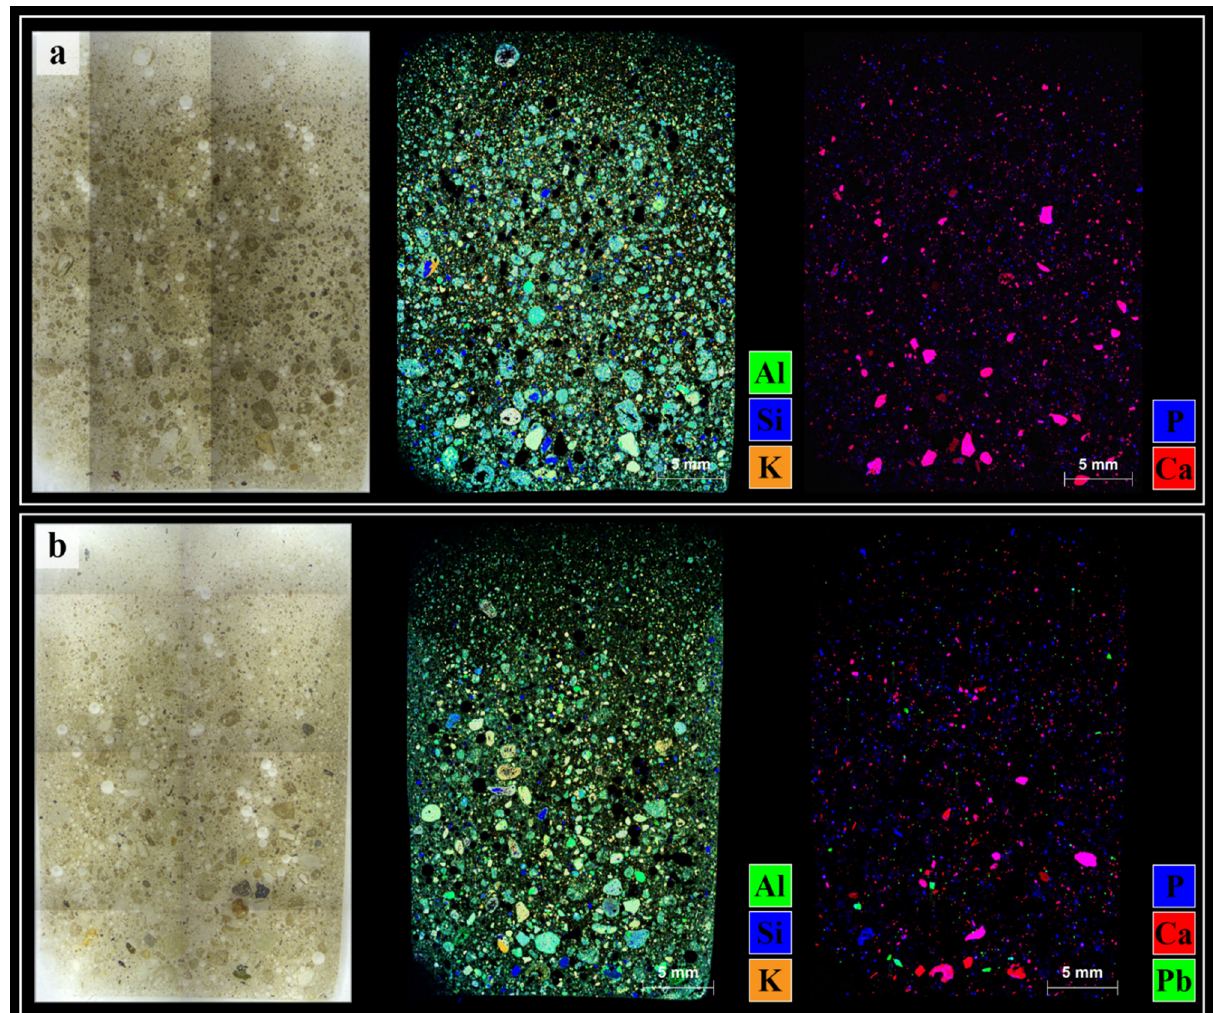
Figure 1. Thin section images (left) and corresponding µXRF maps (middle, right) of S1 ( a ) and S2 ( b ) soils. (( a , b ) middle panels) Overlay of Al (green), Si (blue) and K (orange) distribution maps. (( a , b ) right panels) Overlay of P (blue), Ca (red) and Pb (green) distribution maps. Brighter pixels correspond to higher element concentrations. The co-presence of two or more elements in the same pixels gives rise to different degrees of colour combinations.